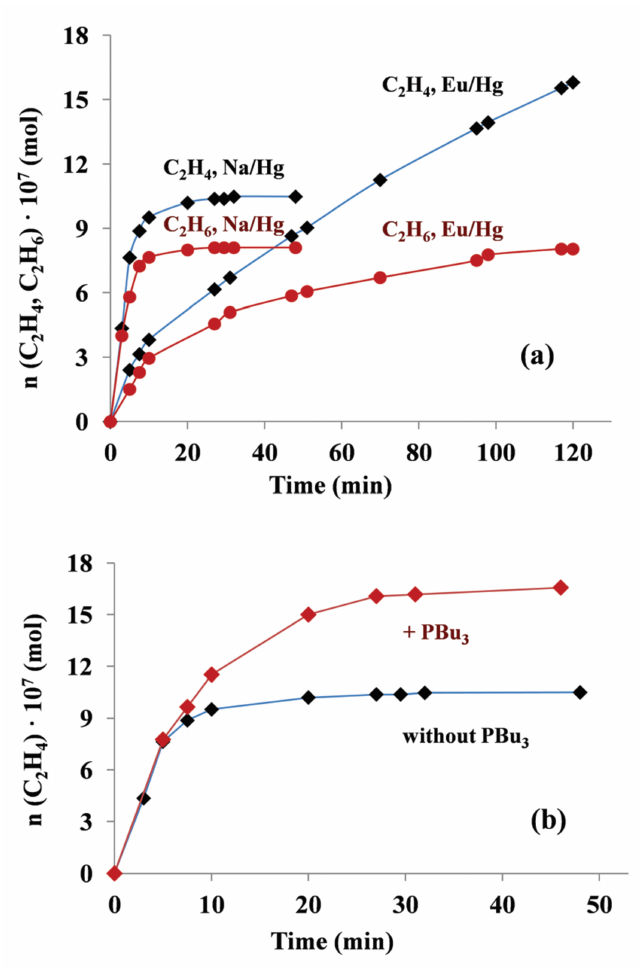
Figure 23. ( a ) Experimental kinetic curves of C 2 H 4 and C 2 H 6 accumulation in the reaction of C 2 H 2 reduction by Na or Eu amalgam in the presence of Mo-complex. ( b ) The effect of PBu 3 addition (C(PBu 3 ) = 5 × 10 − 3 M) on the C 2 H 4 accumulation rate in C 2 H 2 reduction by Na amalgam in the presence of Mo-complex. (Conditions: C(Mo) = 2 × 10 − 5 M; 0.5 mL Eu/Hg (0.9 M) or 0.5 mL